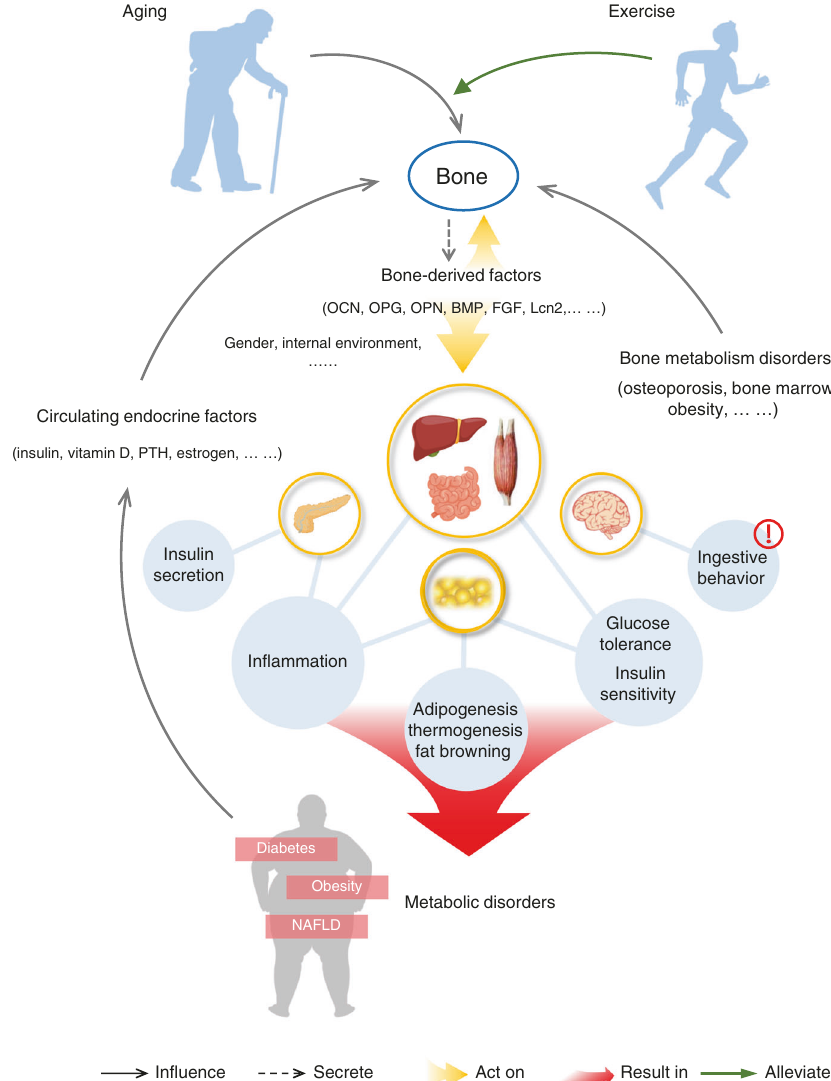
Fig. 5 The network relationship between bone and whole-body energy metabolism. Aging is one of the main causes of bone and whole-body metabolism disorder, and exercise training can alleviate it. Changes in bone metabolism will affect multiple organs and tissues, including the brain (a potential research direction in the future), and lead to metabolic diseases. Metabolic diseases, as well as changes in circulating endocrine factors, can in turn affect bone. On the other hand, bone-derived factors can also be used as autocrine factors to regulate their own metabolic